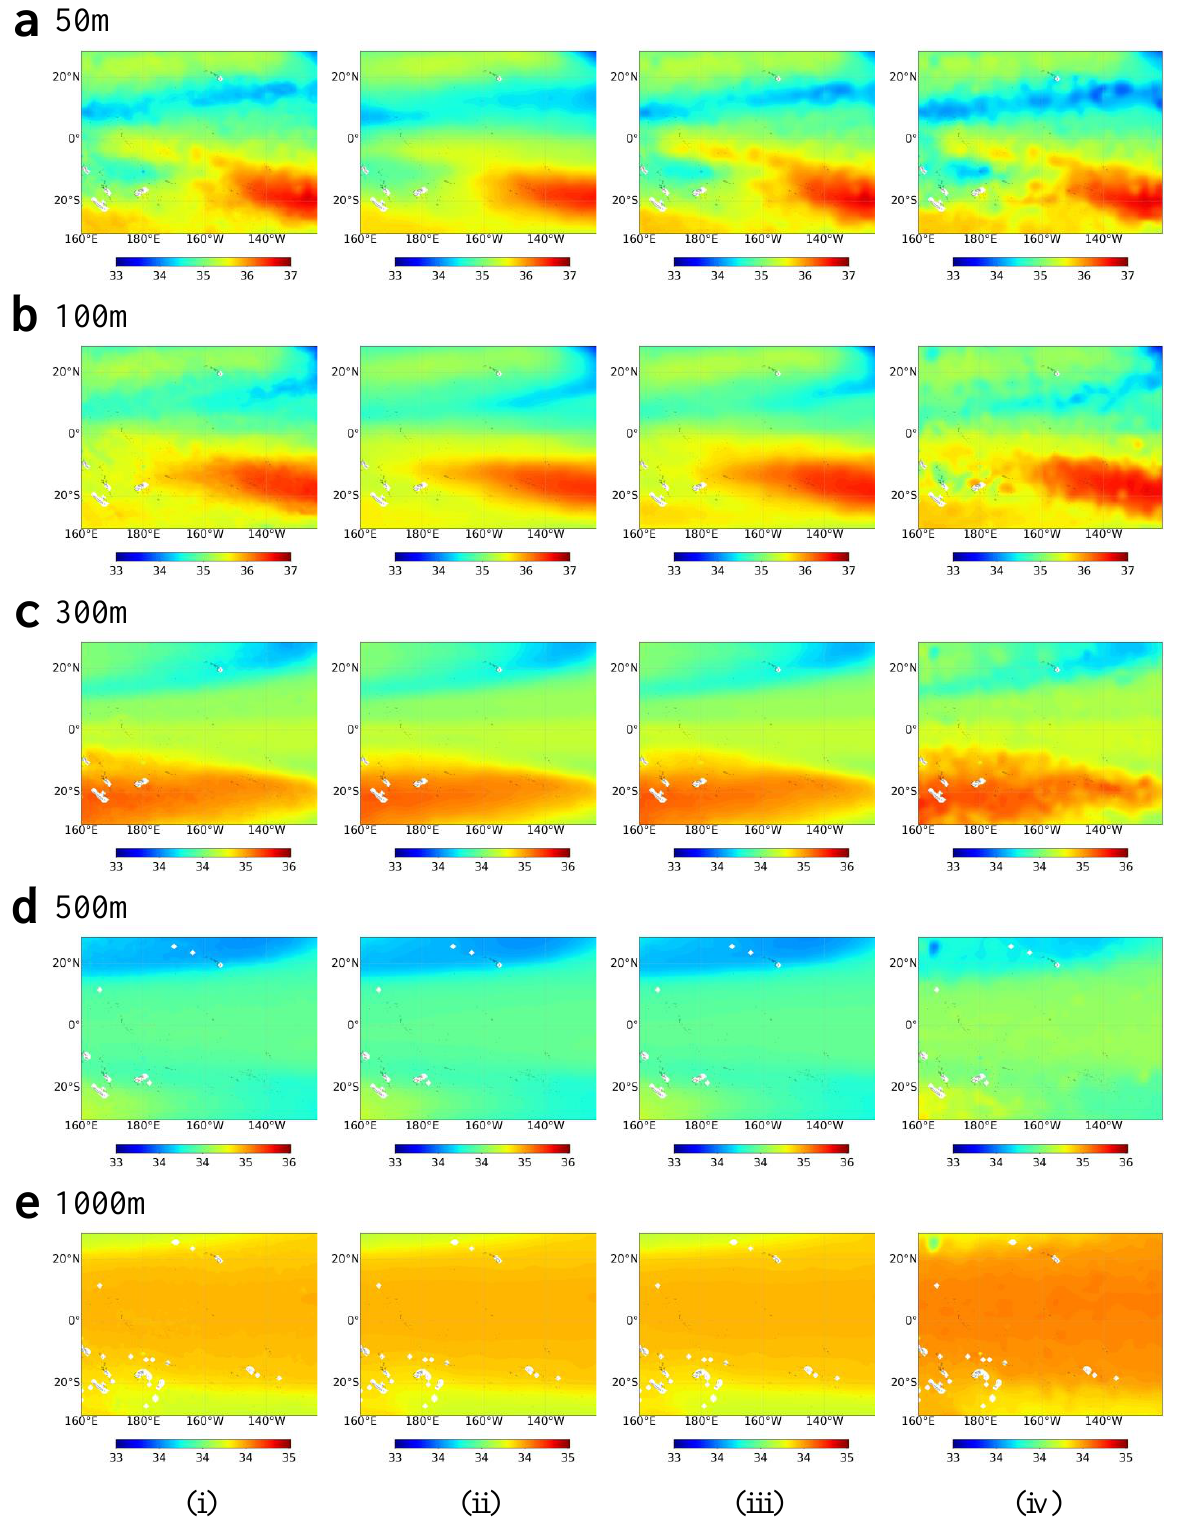
Figure 11. SS spatial distribution of (i) RFs, (ii) LSTM, (iii) ConvLSTM, and (iv) Argo gridded